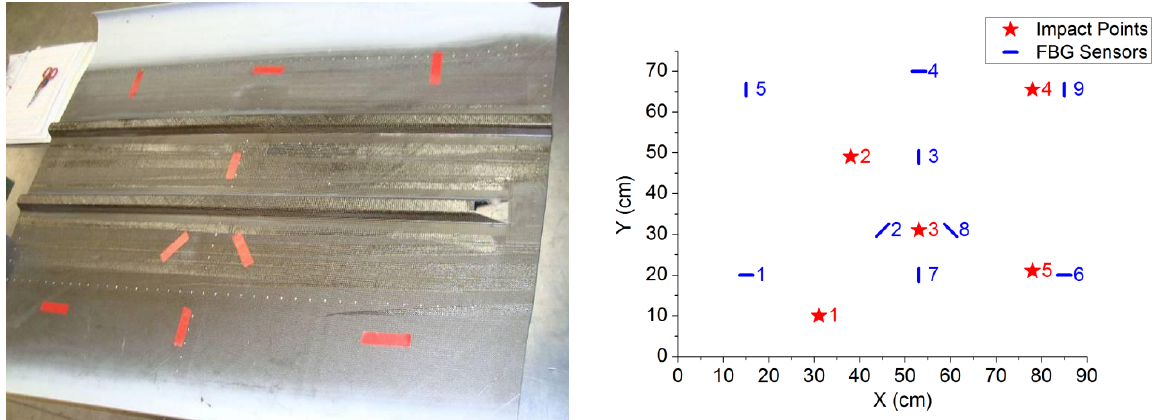
Figure 1. Marking and pre-allocation of the Fiber Bragg Grating on the bottom surface of the aircraft skin.